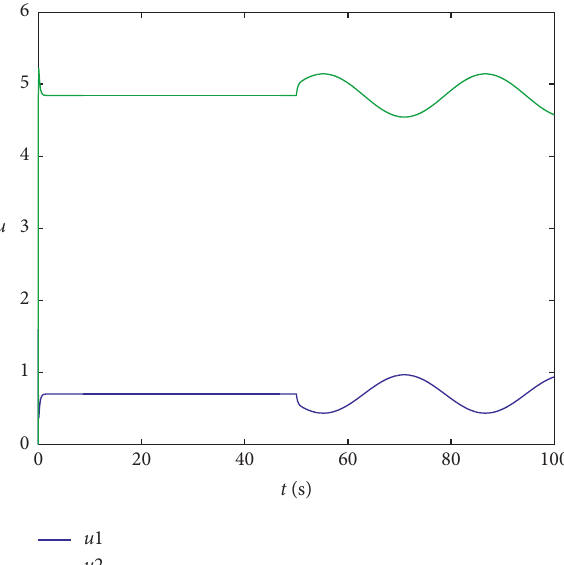
Figure 10: The input signal.